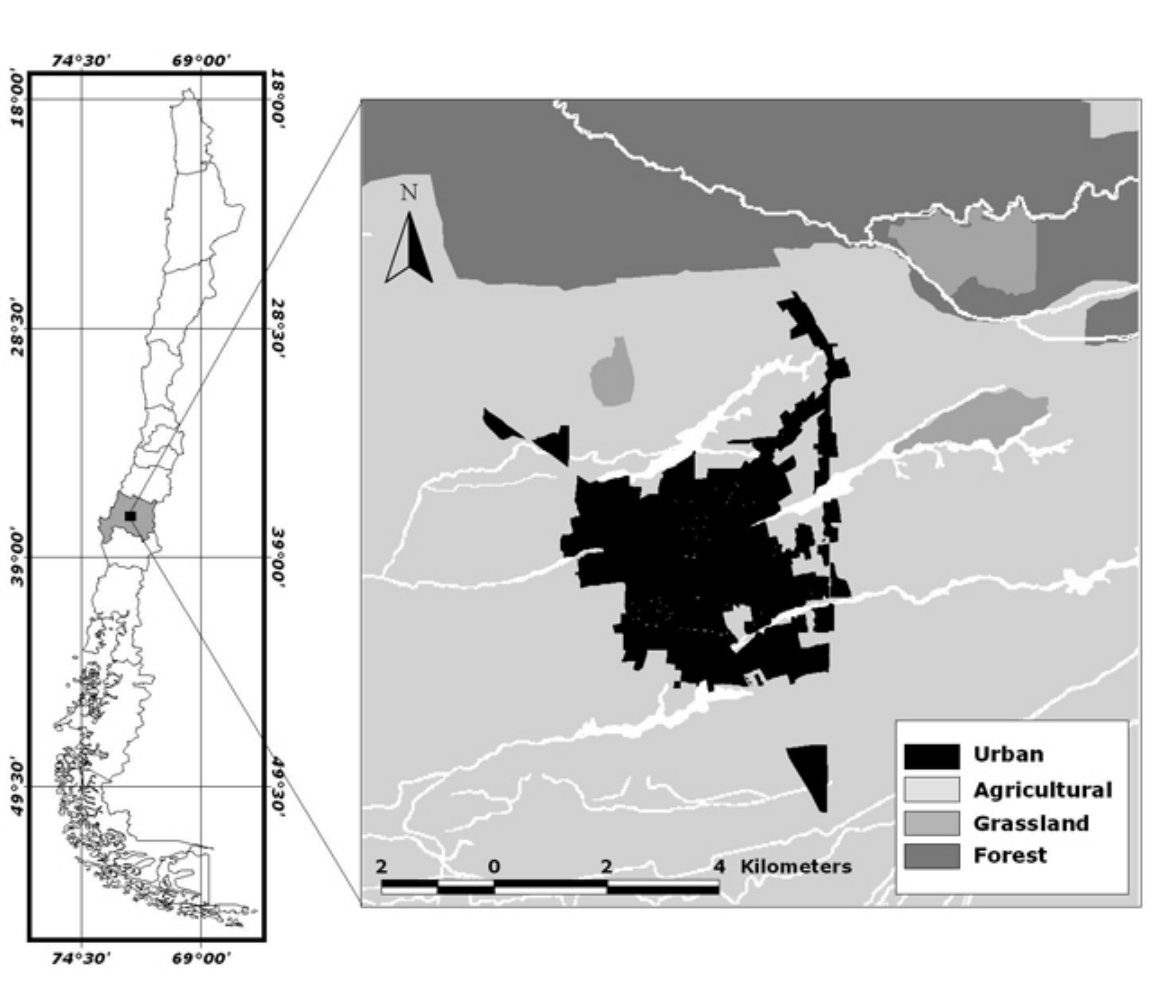
Fig. 1. Study area location in Chile and land use classification in